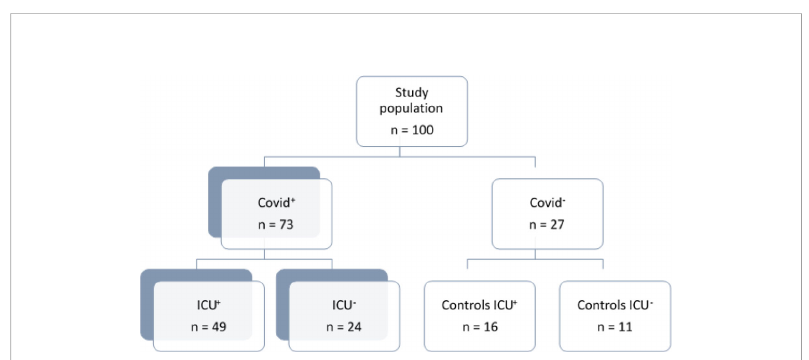
FIGURE 1 Flow chart of the study. Study participants (n=100) were screened for participation during the fi rst surge of the disease (March to May 2020) among 547 patients admitted for COVID either to the emergency department or to the ICU. Informed consent for participation was obtained in 49 COVID+ ICU+ patients, and in 24 COVID+ICU- patients, which were then admitted to the infectious disease department. In parallel, 11 participants were recruited in our staff (as healthy controls, COVID-ICU-), and so were 16 COVID-ICU+ patients that were admitted for non-COVID multiple organ failure requiring mechanical ventilation